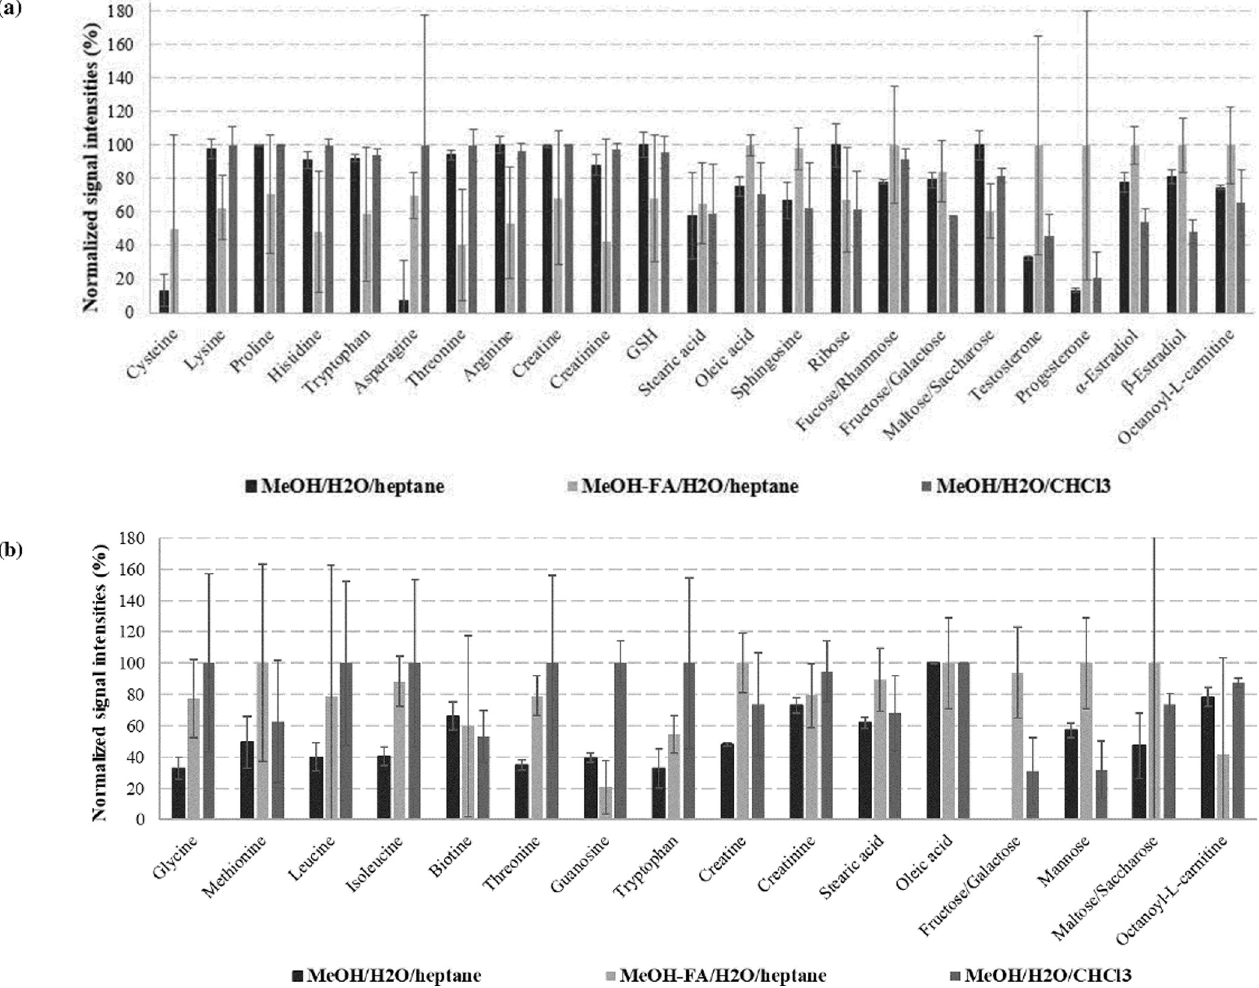
Fig 4. Normalized intensities of internal metabolites analyzed by (a) RPLC(ESI+) and (b) HILIC(ESI-) after extraction (n = 3) with various solvent mixtures (extraction of 50 mg of fish spiked at 500 μ